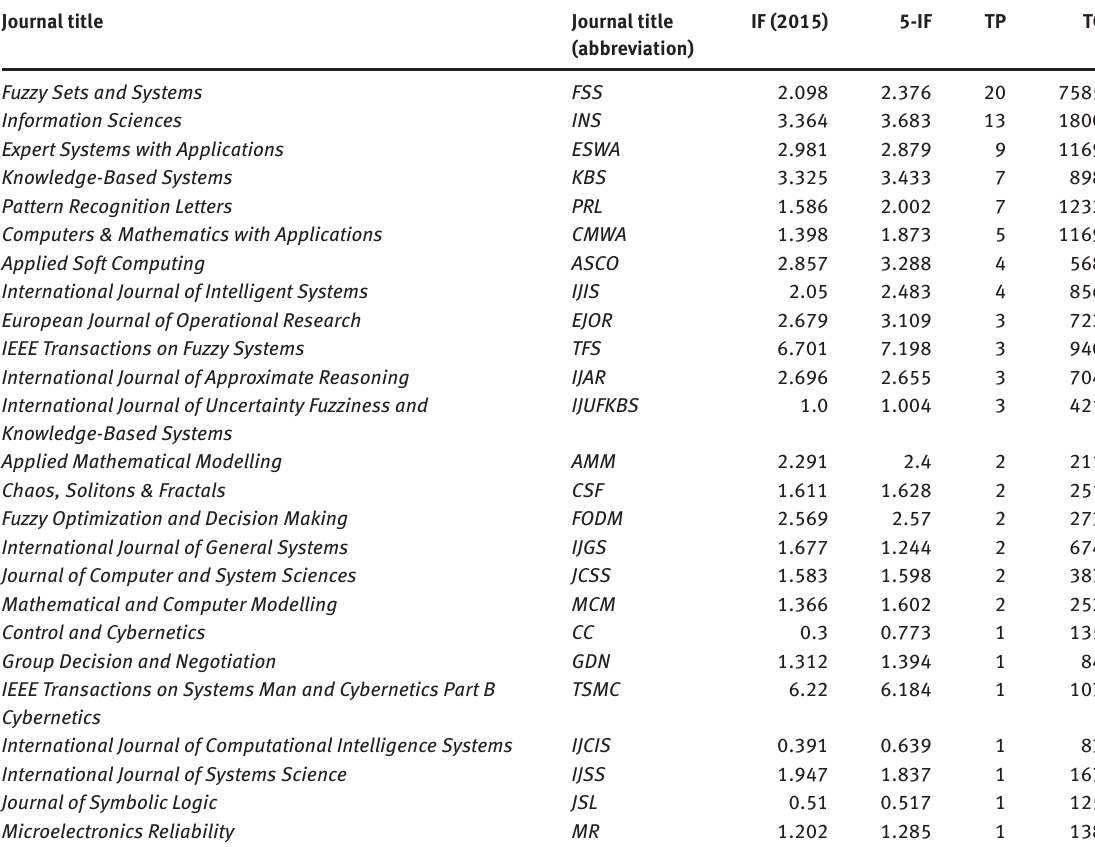
Table 2: Journals with the Top 100 Cited Intuitionistic Fuzzy Articles.